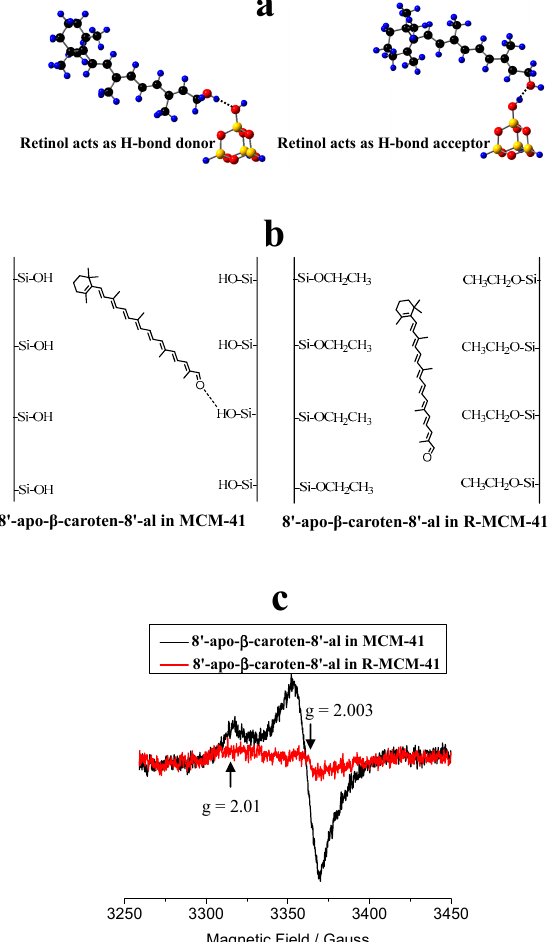
Figure 7. To increase the photostability of the carotenoids in supramolecular complexes, the formation of H-bonds should be avoided, especially when the carotenoid acts as a H-bond donor. Nonpolar environments also favor photostability. ( a ) Two types of H-bonds for retinol adsorbed on the surface of MCM-41. H: blue, O: red, C: black and Si: yellow. Adapted from Ref. [73]. ( b ) Cartoons for 8’-apo- β -caroten-8’-al imbedded in the pores of MCM-41 and in the modified surface of MCM-41 with –SiOH groups replaced by –SiOCH 2 CH 3 groups designated as R-MCM-41. ( c ) EPR spectra after 10 min photo-irradiation of 8’-apo- β -caroten-8’-al adsorbed on activated MCM-41 and R-MCM-41, measured at 77 K. The backgrounds before photo-irradiation are subtracted. Adapted from Ref. [73]. Explanation of result according to [73]: the strong peak with g value of about 2.003 and peak to peak width of about 15 Gauss is the typical signal of a carotenoid radical cation. The weak peak with g value of about 2.01 could be attributed to a peroxy radical produced in a reaction of the carotenoid radical cation with O 2 (O 2 cannot be removed completely even under high vacuum) during photo-irradiation, and / or due to the reaction of a neutral radical (the radical cation of a carotenoid can lose a proton under photo-irradiation to produce the neutral radical) with O 2 .